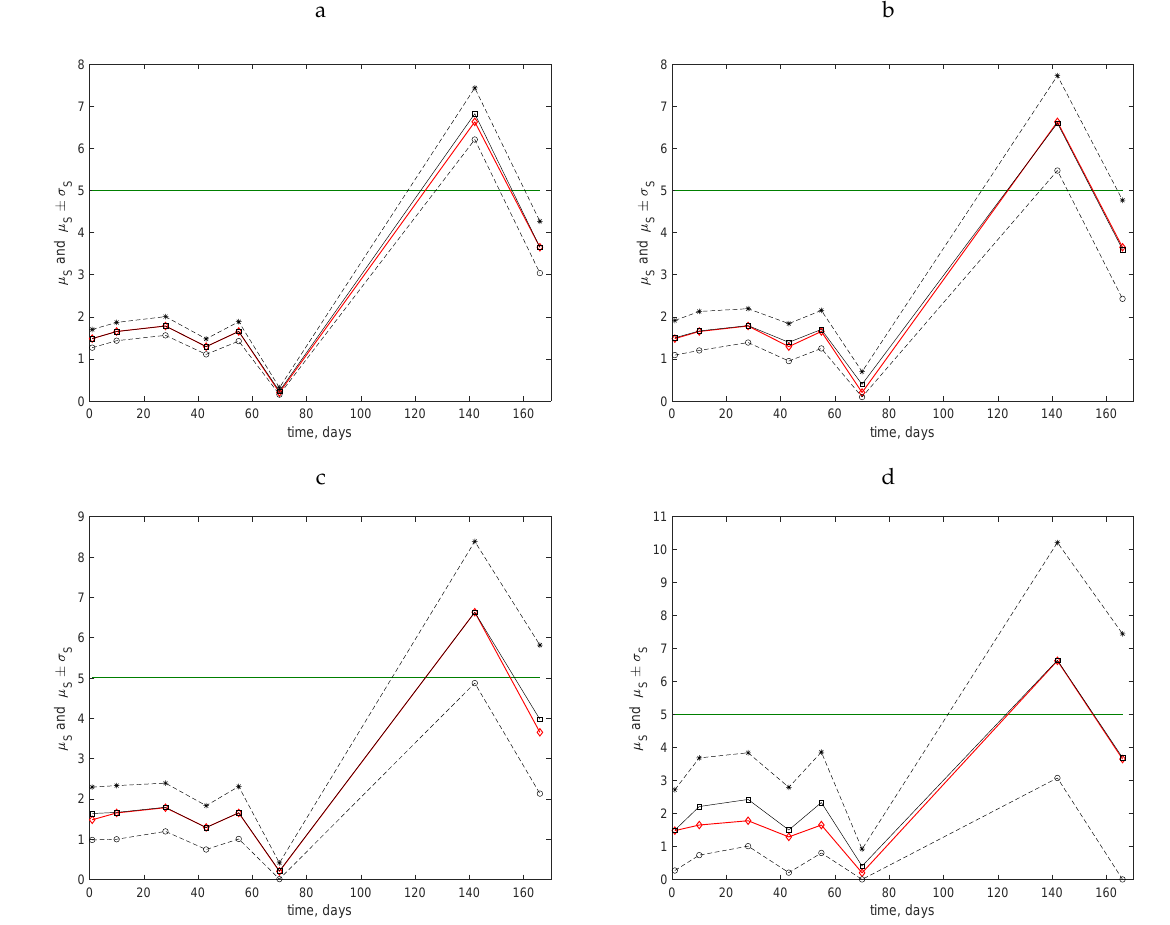
The results obtained for four coarse grids using the data from the Uppington field are shown in Figure 6: (a) for N = 25, (b) for N = 9, (c) for N = 4, and (d) for N = 1. In all of these cases, the mean value µ S (solid black line, open squares) is presented along with the ‘exact’ value S of the average trap count (solid red line, open diamonds) calculated on the original grid of N = 100 locations. The range µ S ± σ S is shown by the dashed lines. The solid green line shows the hypothetical threshold value S T = 5. b